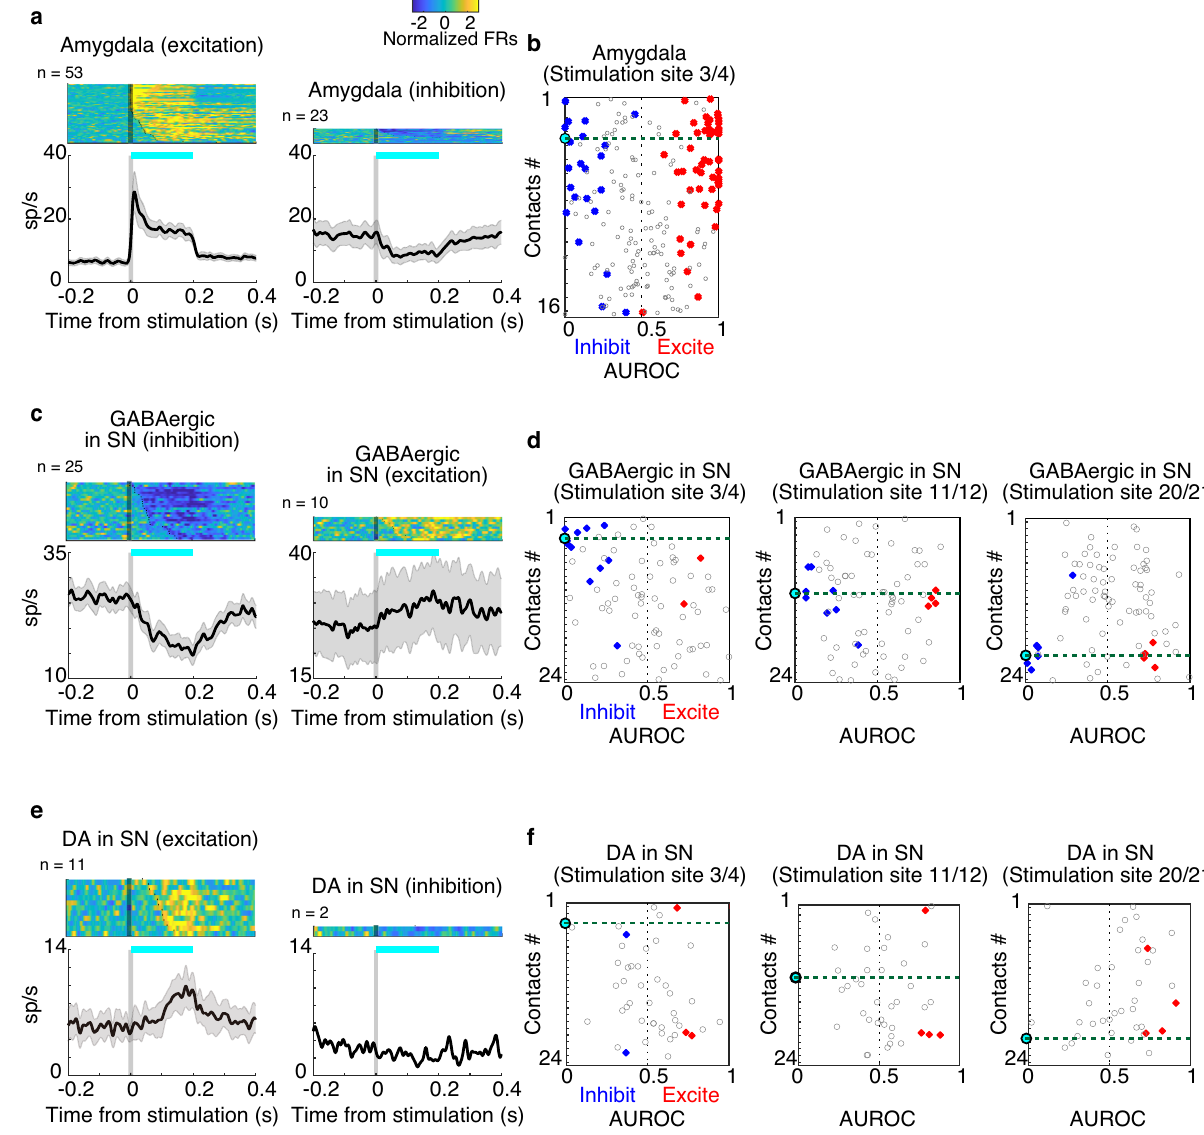
Fig. 3 | Neuronal modulation by optogenetic stimulation. a Population activity of amygdala neurons that were excited (left) or inhibited (right) by optogenetic stimulation. Spike activity was smoothed with a Gaussian kernel ( σ =10ms). The shaded gray area indicates ±1 SEM forthe averaged population activity. Responses of individual neurons (upper) were converted to the color scale and sorted by modulation latencies (dots). The duration of optical stimulation was 200ms (cyan bar). b Data from combined all sessions recording amygdala neurons while opto- genetically stimulating the amygdala. The degree of the modulation by the sti- mulation is de fi ned as the area under the receiver operating characteristic curve (AUROC) based on the activity in stimulation trials vs. control (sham stimulation) trialsforeachneuron.EachdotindicatestheAUROCscoreineachneuron.Thered putative GABAergic neurons (Fig. 4e), but not for putative DA neurons (Fig. 4f). Among optically activated putative GABAergic neurons (Fig. 4e), cells that were close to the O-stim (within 0.25 mm; n =17/25, 68 %) were inhibited quickly (mean: 47.6 + − 31.9ms). The remaining neurons beyond 0.25mm ( n = 8/25, 32 %) were inhibited signi fi cantly, but more slowly (mean: 93 + − 51.3 ms, t -test P =0.0453). These data suggest the direct connections of amygdala neurons to GABAergicneuronsinSN,asshowninFig.4c.Inthisschematicdiagram, most amygdala neurons (shown by black circles, e.g., n =4) are infected with viral vector (blue ovals) and express ChR2 in their axons (blue Nature Communications| (2023)